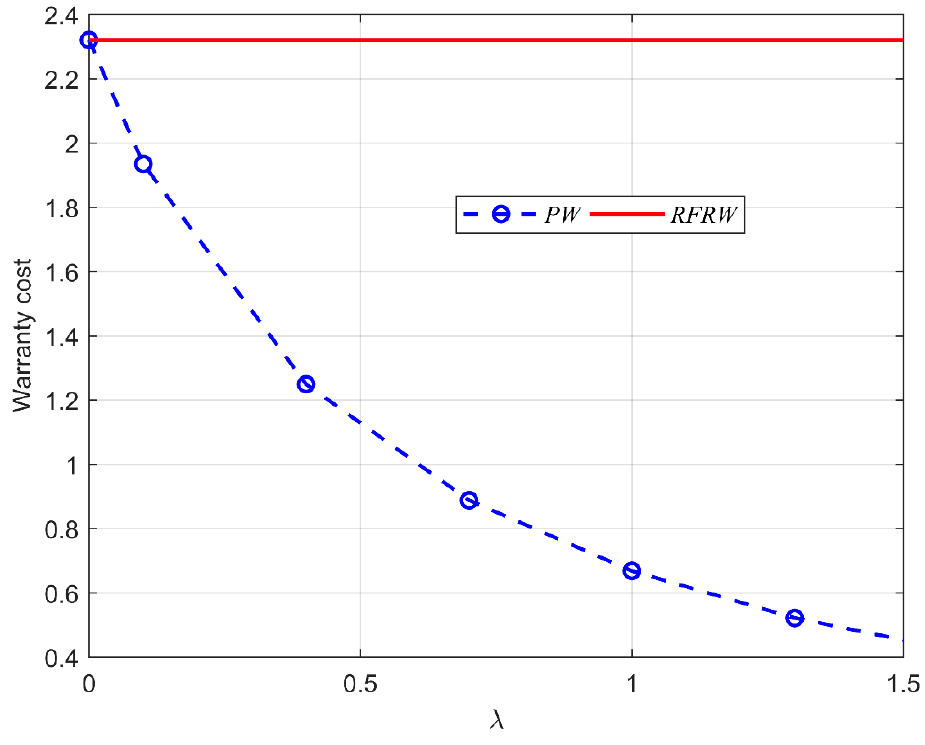
Figure 2. Warranty cost variation tendency.